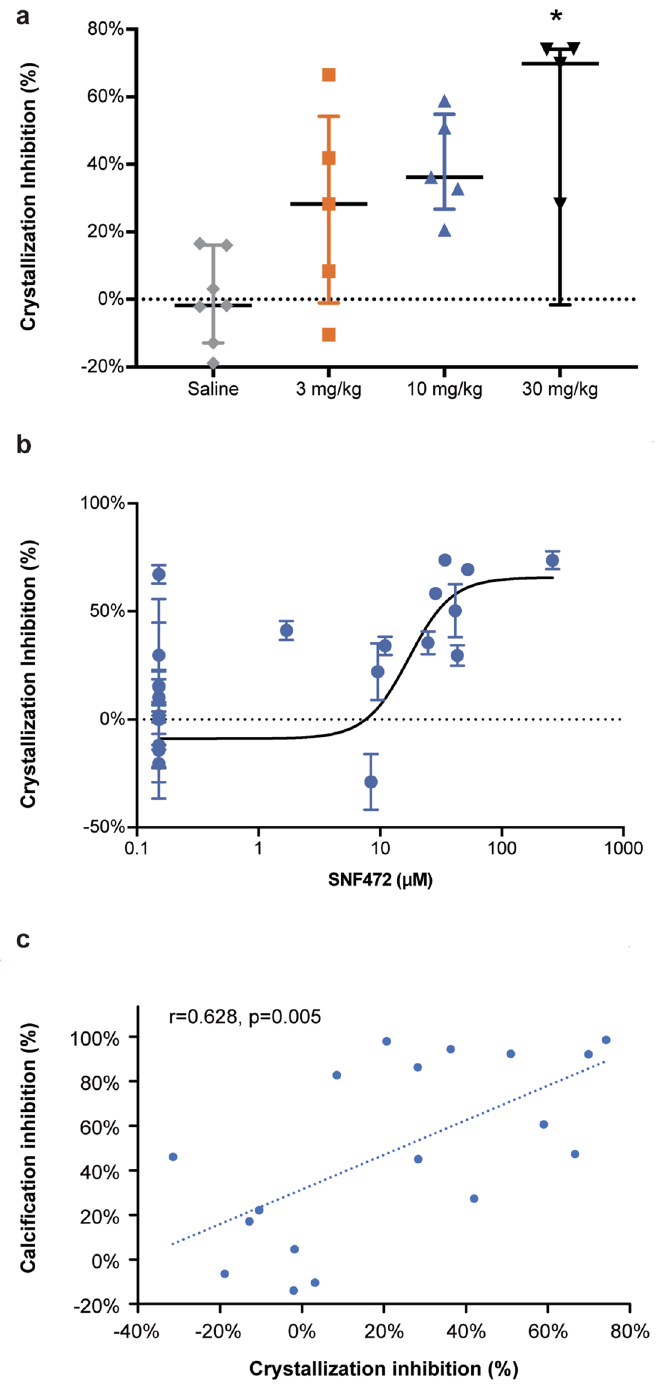
Figure 1. A correct version of the original Figure